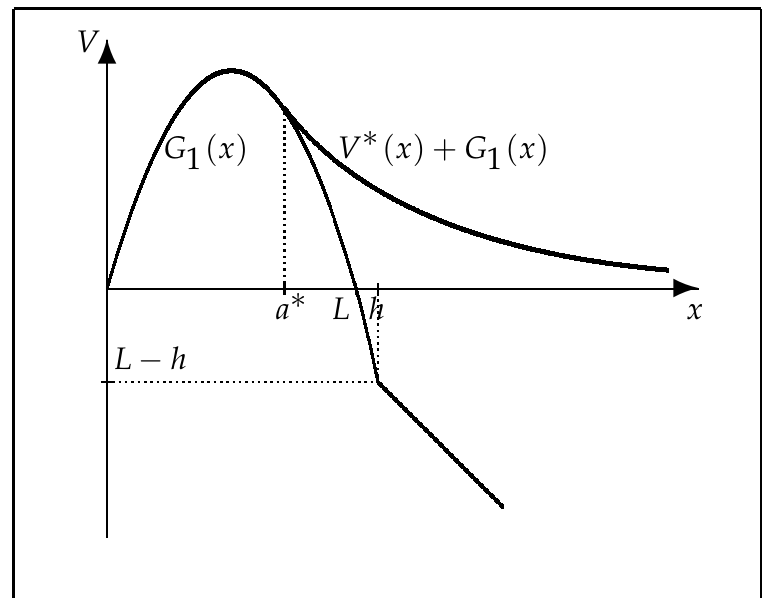
Figure 1. A computer drawing of the value function V ∗ ( x ) + G 1 ( x ) .